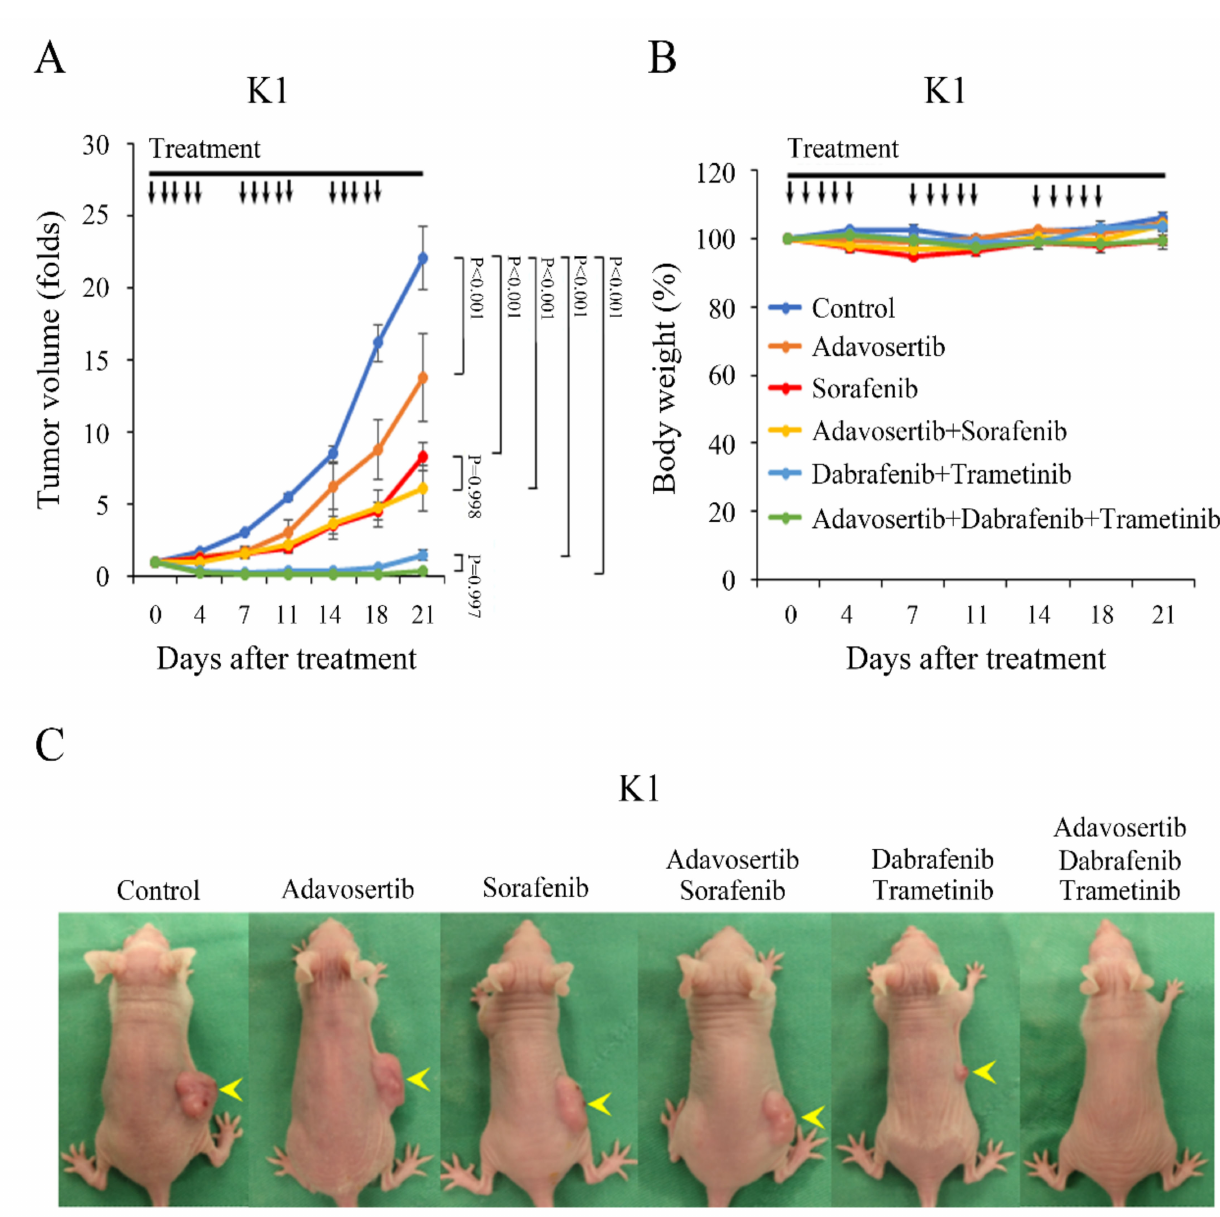
Figure 6. Adavosertib retards subcutaneous xenograft growth in a papillary thyroid cancer model. ( A ) Nude mice bearing K1 xenografts were treated with oral gavage of placebo, adavosertib (50 mg/kg), sorafenib (40 mg/kg), the combination of adavosertib and sorafenib, dabrafenib (30 mg/kg) plus trametinib (0.6 mg/kg), or triple combination of adavosertib, dabrafenib, and trametinib for three cycles of 5 days on and 2 days off. Adavosertib, sorafenib, the combination of adavosertib and sorafenib, dabrafenib plus trametinib, and the triple combination of adavosertib, dabrafenib, and trametinib significantly inhibited K1 tumor growth when compared with vehicle treatment ( p < 0.001 for both comparisons). Adavosertib and sorafenib combination therapy did not demonstrate superior effects in reducing K1 tumor growth over sorafenib monotherapy ( p = 0.998). Tumor volumes were also similar between dabrafenib plus trametinib and triple combination therapy ( p = 0.997). ( B ) Adavosertib, sorafenib, the combination of adavosertib and sorafenib, dabrafenib plus trametinib, and triple combination therapy did not significantly alter body weight by the close of the study. ( C ) Photographs of the representative mice with K1 tumors (arrowhead) were taken on day 15. Arrow, placebo, adavosertib, sorafenib, the combination of adavosertib and sorafenib, dabrafenib plus trametinib, and the triple combination of adavosertib, dabrafenib, and trametinib